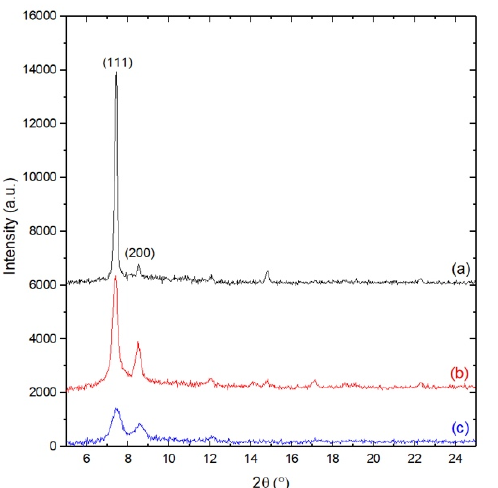
Figure 1. X-ray diffraction patterns of ( a ) UiO-66-H, ( b ) UiO-66-NH 2 and ( c ) UiO-66-NO 2 films.